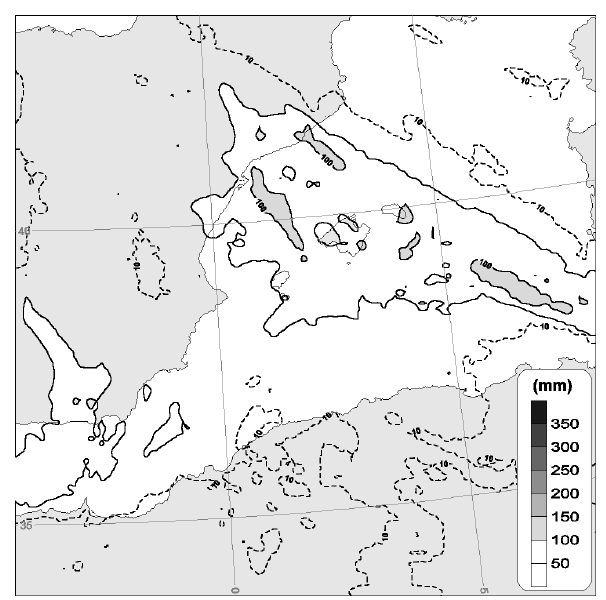
Fig. 19. Evolution of the precipitable water (mm) horizontally integrated over eastern Spain for the control run (heavy solid line with crosses), the weakened cutoff low precursor trough experiment (solid line with stars), the experiment with no evaporation (solid line with squares) and the experiment with flat topography (doted line with triangles). Dates are given in the DD/HH format referring to the HH:00UTC hour of the DD day of October 2000.